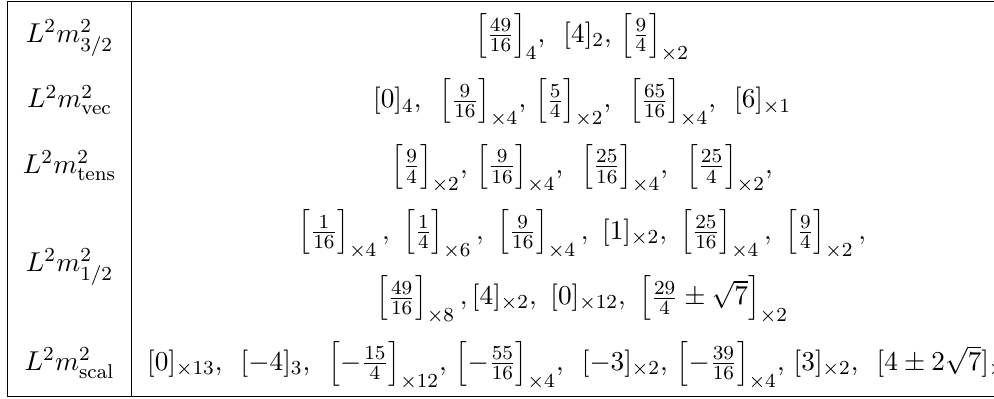
Table 11 . Masses for the AdS vacuum